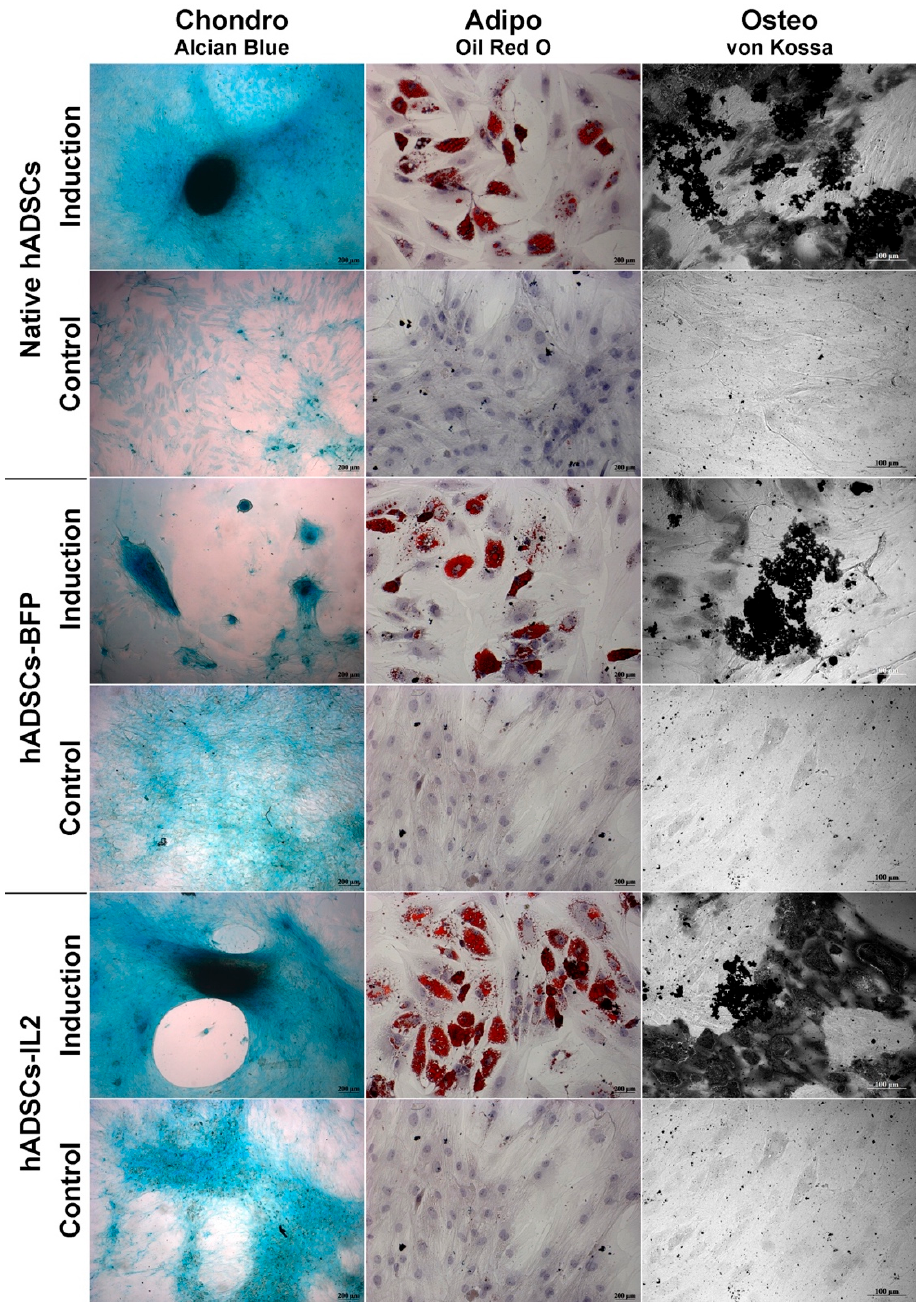
Figure 3. Chondrogenic, adipogenic and osteogenic differentiation of hADSCs. Prior to image anal- ysis by phase contrast microscopy, cells were differentiated as follows. Chondrogenic differentia- tion was determined by staining with Alcian blue on day 21 after seeding. For adipogenic differen- tiation, native and IL2-genetically modified cells were cultured in the reprogramming medium for 14 days. At day 14, cells were fixed and stained with Oil Red O. For osteogenic differentiation, cells were cultured in the reprogramming medium for 28 days. At day 28, cells were fixed and analyzed by von Kossa staining (chondrogenic and adipogenic differentiation: scale bar, 200 μ m osteogenic differentiation: scale bar, 100 μ